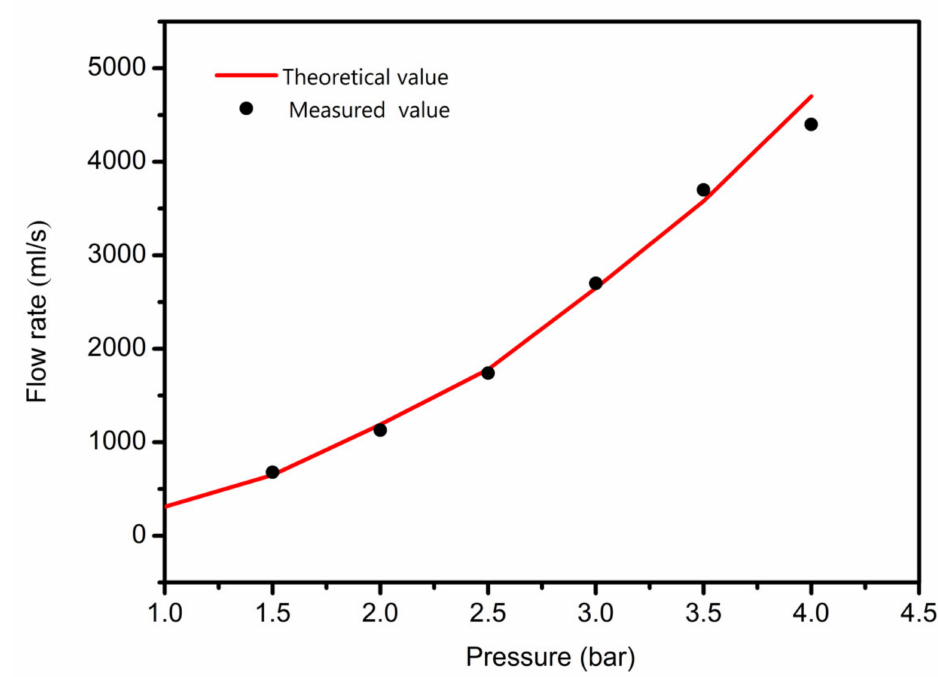
Figure 7. The relationship between the flow and